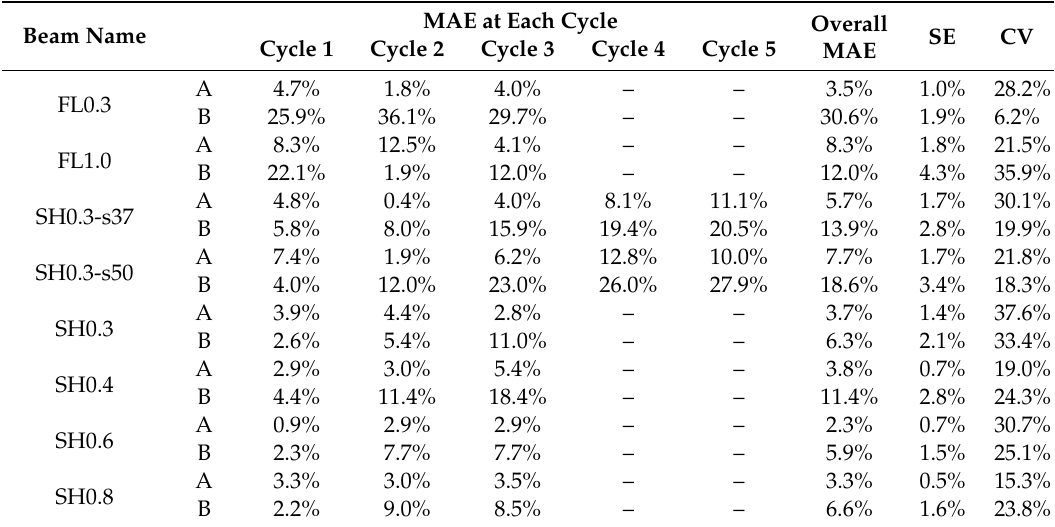
Table 7. Error calculation in the prediction of secant sti ff ness, K sec .